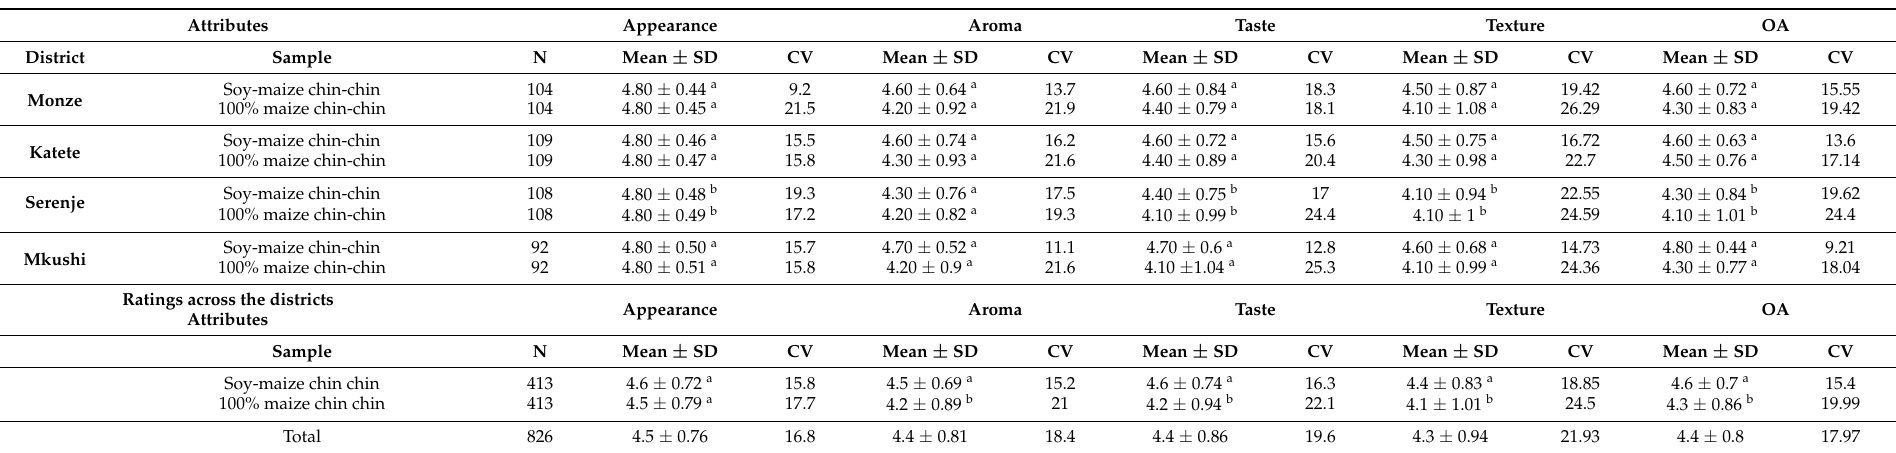
Table 6. Consumer preference ratings for maize chin-chin products by district and across the districts.